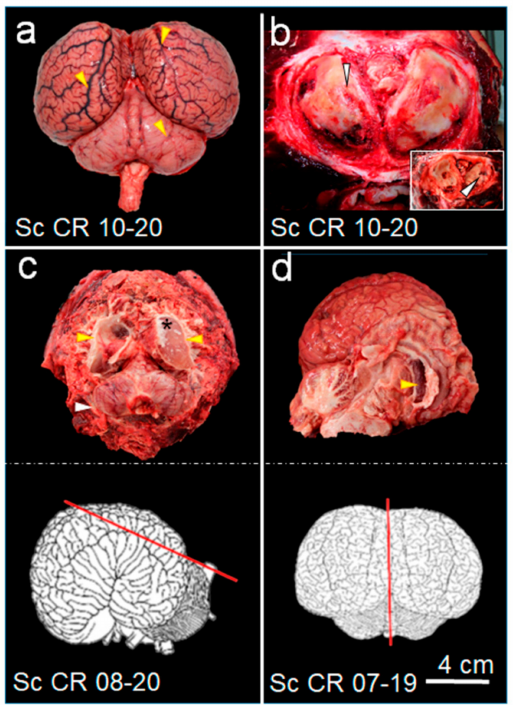
Figure 5. The brain and brain sections of S. coeruleoalba (S.c) striped dolphins with neurobrucellosis. ( a ) There are mildly thickened and hyperemic meninges over the cerebrum and cerebellum (yellow arrows). ( b ) Caudal view of the skull showing the occipital condyles and the corresponding atlas vertebrae (insert) with osteomyelitis and osteolysis (white arrows). ( c ) Oblique section of a frozen brain showing severe ventriculomegaly (yellow arrows). The right lateral ventricle is filled with frozen cerebrospinal fluid (asterisk); part of the skull bone is depicted (white arrow). The red line crossing the brain scheme, depicted at the bottom of the figure, indicates the plane of the surgical section. ( d ) Sagittal section of the brain with moderate ventriculomegaly, showing the rostral segment of the left lateral ventricle dilated (yellow arrow) of case CR 07-19. The red line crossing the brain scheme, depicted at the bottom of the figure, indicates the plane of the surgical section.